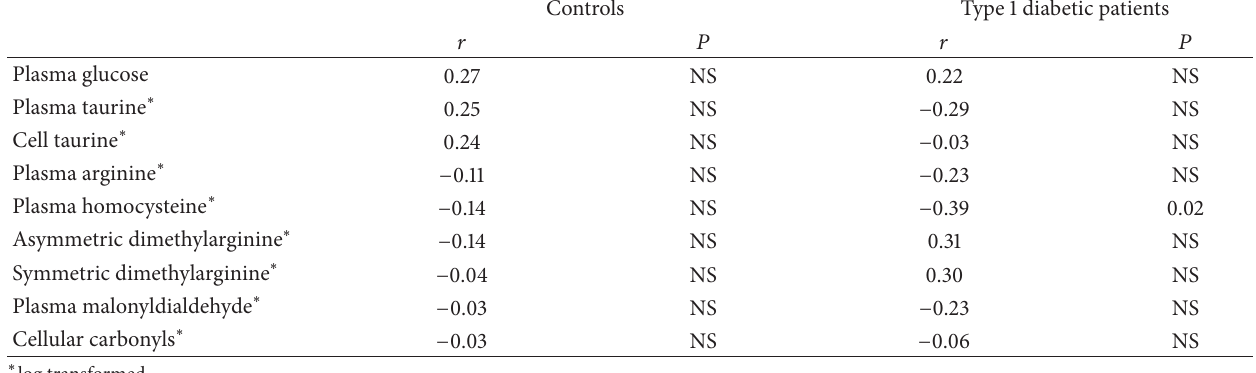
Table 2: Correlation coefficients between TauT mRNA expression in MPCs of controls or type 1 diabetic patients and plasma glucose and markers of endothelial function or oxidative stress.